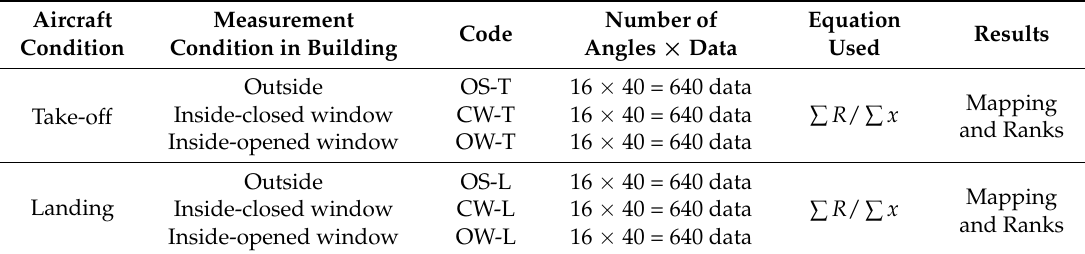
Table 2. The Relative Value Mapping and Rating